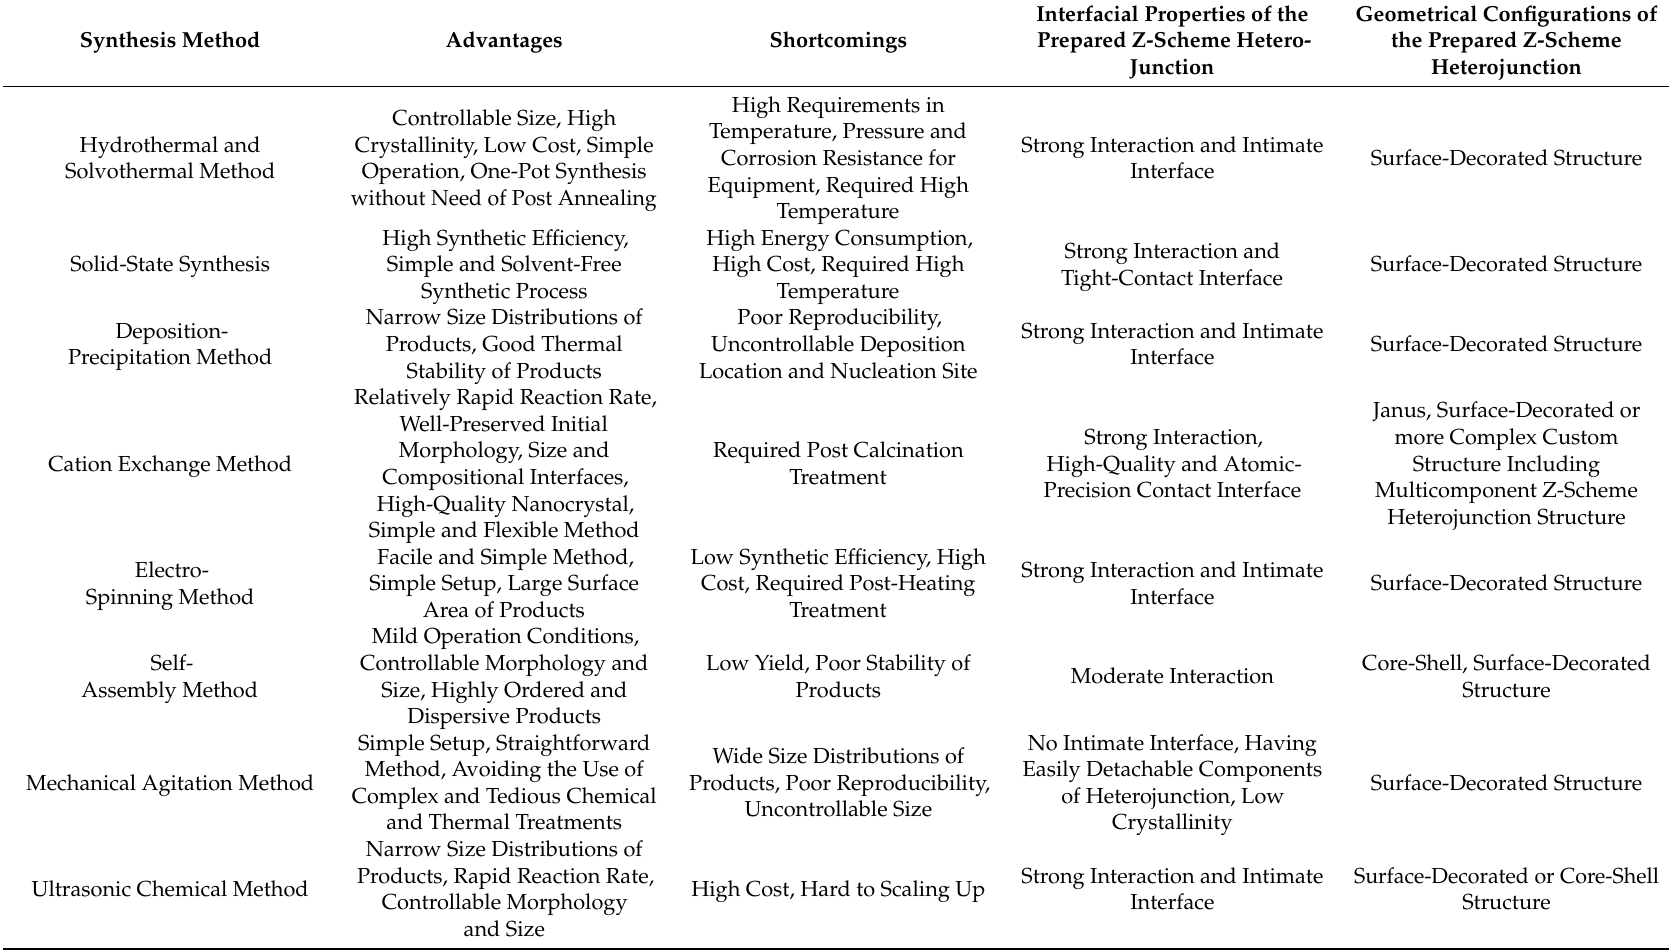
Table 1. Comparison of extensively used synthesis methods of direct Z-scheme